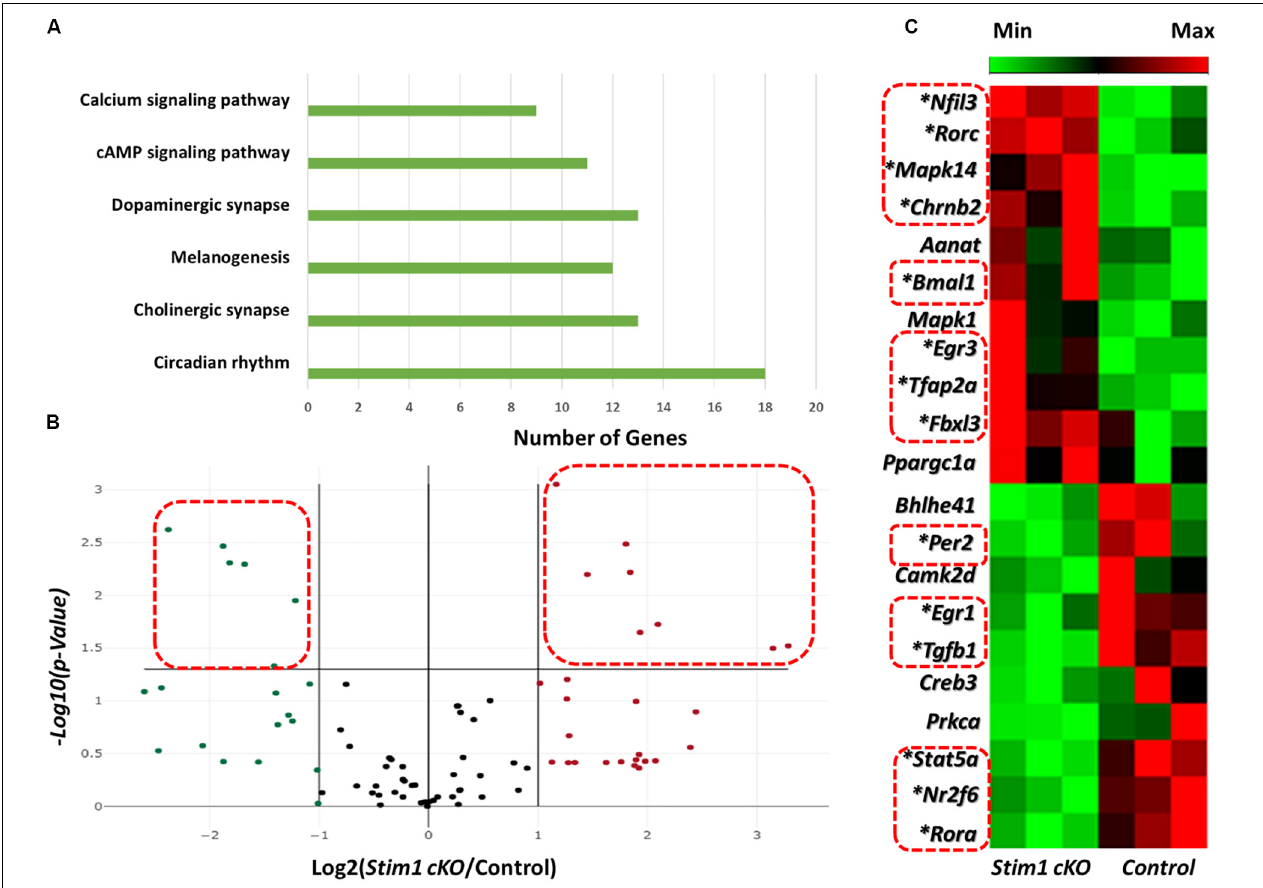
FIGURE 1 | Effects of Stim1 KO on the gene expression profiles in ameloblasts. The expression change of 84 genes in ameloblasts from Stim1 cKO and control mice was performed by real-time PCR based array analysis. (A) A bar diagram showing the functional clustering of the examined genes in the 6 most enriched signal transduction pathways according to the Gene Ontology and KEGG pathway analysis performed by the DAVID software (B) A volcano plot for the examined genes in total, black dots indicates genes with unchanged gene expression in Stim 1 cKO versus control; the genes with at least two fold change [(i.e., Log2 ( Stim1 cKO /Control) > 1 or < − 1] were represented as red dots for the upregulated genes and in green dots for the downregulated genes; the genes were deemed to be significantly differentially expressed if presented with at least two fold change and a P- value < 0.05 [i.e., − Log 10 ( P -Value) > 1.305, represented by the dots within the dashed red rectangles]. (C) A cluster heatmap showing the expression changes in some of the examined genes in Stim1 cKO ameloblasts against the control group. A total of 14 genes were found to be significantly differentially expressed in Stim1 cKO ameloblasts compared to the control group ( P < 0.05, labeled by asterisks and within dashed red